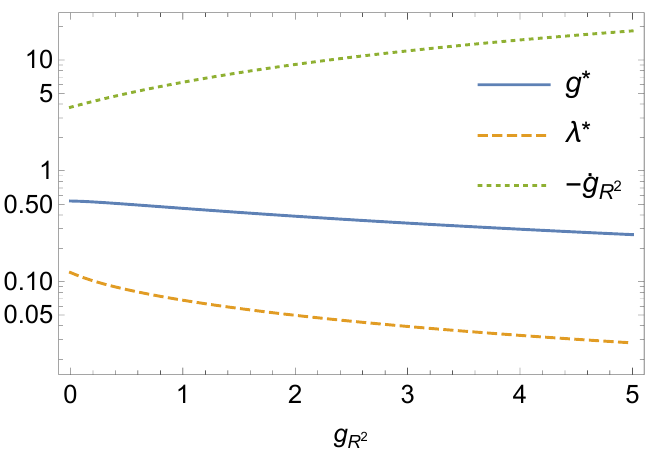
Figure 2: The partial fixed points for g (solid blue line) and λ (dashed orange line) as well as the beta function ˙ g (dotted green line) evaluated on the partial fixed R 2 point, as a function of positive g . The dashed grey horizontal line indicates R 2